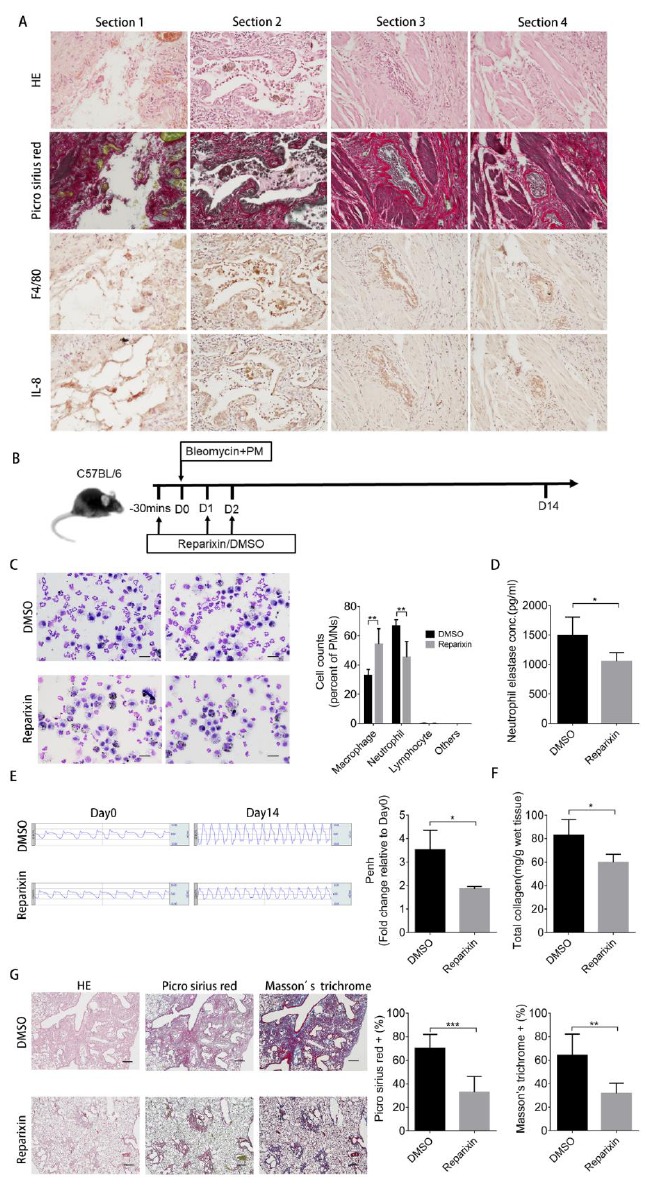
concentration of day 2-BALF (Figure 6D). Moreover, reparixin improved lung function (Figure 6E) and ameliorated pulmonary fibrosis as assayed by total collagen content (Figure 6F) and histochemical stains of fibrosis markers (Figure 6G) on day 14-lung tissues.